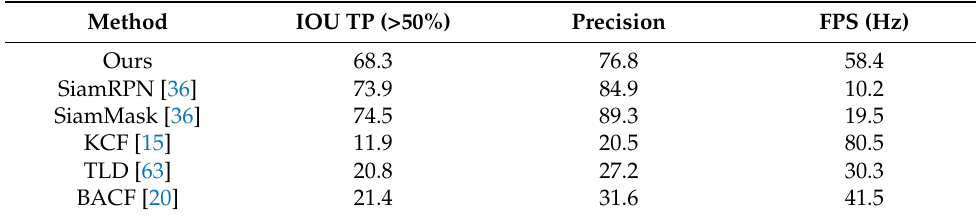
Table 6. Performance comparison results between our tracker and common trackers.